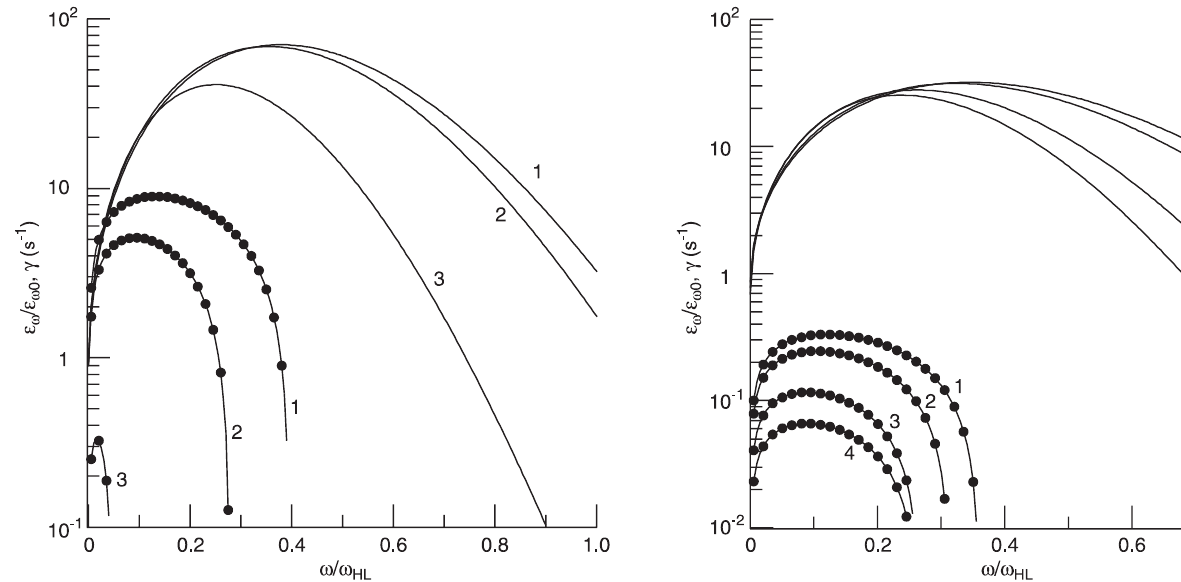
Fig. 8. The dependencies of growth rate ( lines with dots ) and wave intensity on frequency for weak di(cid:128)usion for di(cid:128)erent u values D v = v 0 (cid:136) 0 : 6 ; u (cid:25) 7 : 8 (cid:14) ; u (cid:25) 8 : 9 (cid:14) ; u (cid:25) 14 : 5 (cid:14) ; u (cid:25) 20 : 5 (cid:14) ; other 1 2 3 4 parameters as in